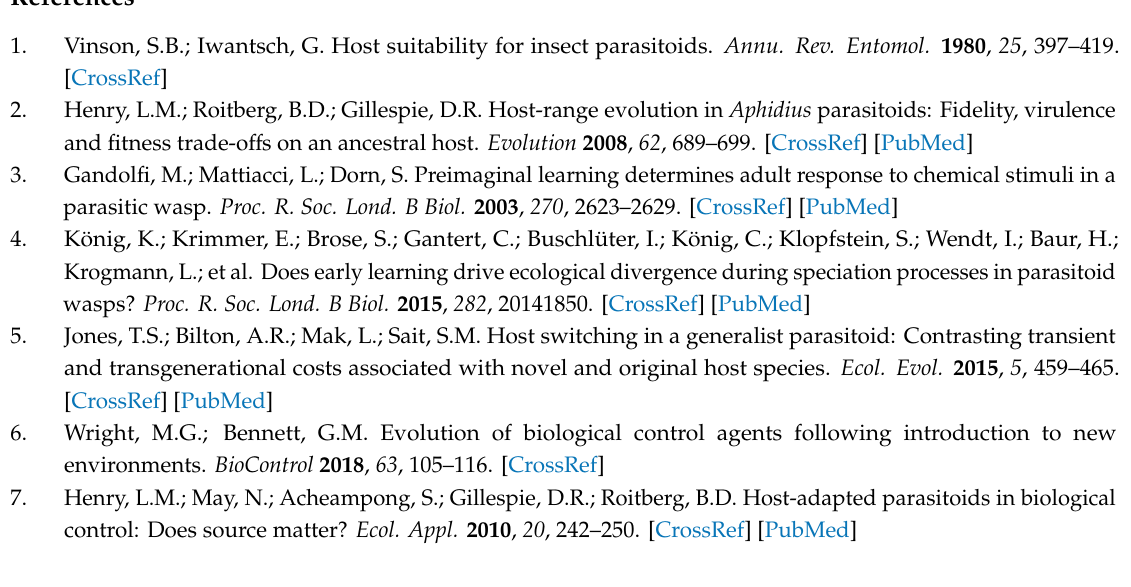
Table S1: Detailed experimental